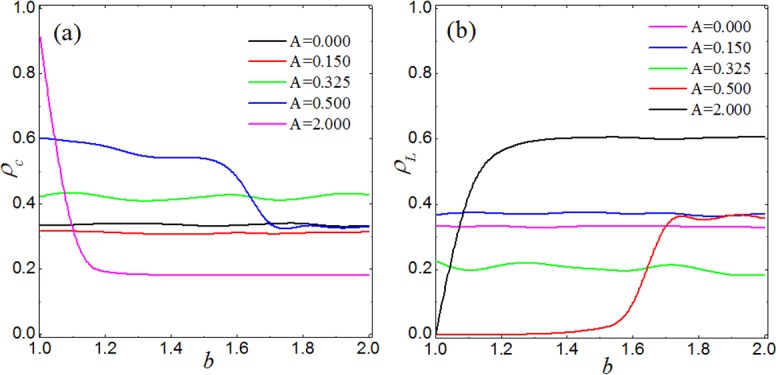
Average fractions of cooperation (panel (a)) and loners (panel (b)) as a function of b for different values of the aspiration A, as obtained by means of simulations on square lattices.